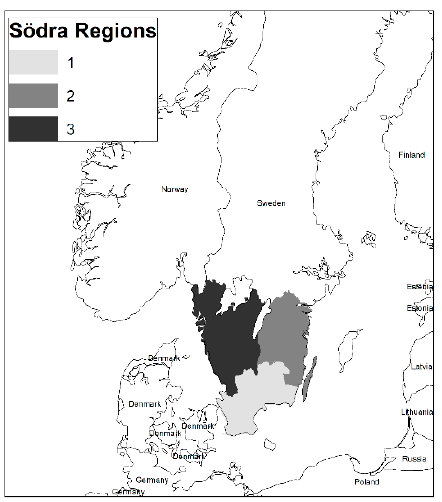
Figure 1. The distribution of forest owners associated with the Södra company in southern Sweden, showing management regions 1–3.